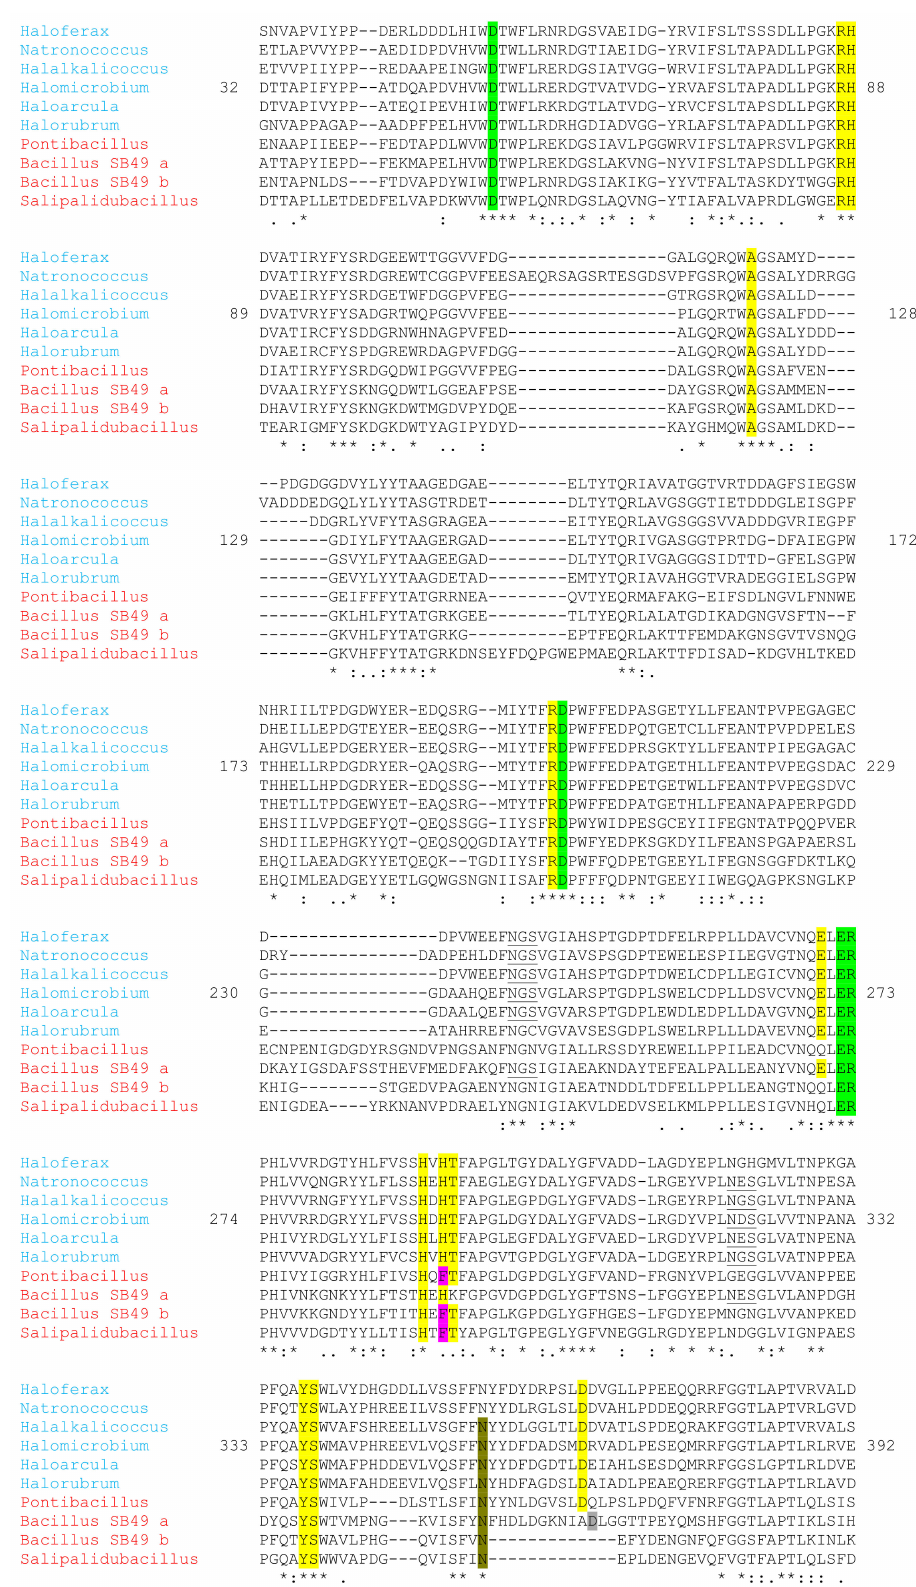
Figure 7. Partial multiple alignment of a number of Haloarchaean (blue) and Gram-positive bacterial (red) GH68 members all showing (potential) inulosucrase signatures. Haloarchaea include Haloferax gibbonsii ARA6, Natronococcus amylolyticus , Halalkalicoccus jeotgali , Hmc Isc, Haloarcula sp. CBA1115 and Halorubrum saccharovorum . Gram-positive bacteria